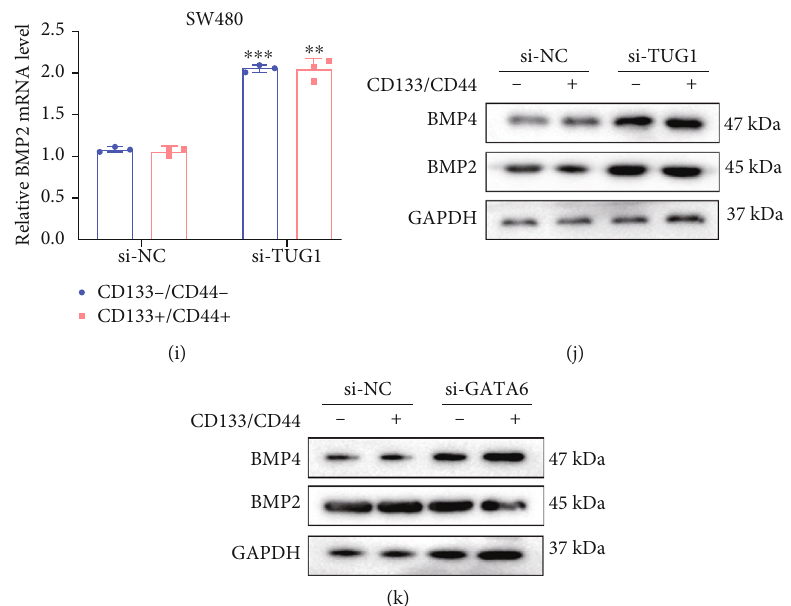
Figure 3: Analysis of the interaction between lncRNA TUG1 and GATA6. (a) RNA Interactome Database and COAD colon cancer database were applied to predict the transcription factors that had potential interactions with lncRNA TUG1 and were highly expressed in CRC. (b) RNA pull-down assay was conducted to verify the interaction between lncRNA TUG1 and ETV4, ASCL2, GATA6, and SOX9. (c) Veri fi cation of the interaction between lncRNA TUG1 and GATA6 by RNA immunoprecipitation assay. (d, e) si-TUG1 was transfected into CD133 - /CD44 - or CD133 + /CD44 + isolated from SW480 cells. The mRNA and protein levels of GATA6 were analyzed using qRT-PCR and Western blot. (f, g) si-TUG1 was transfected into CD133 - /CD44 - or CD133 + /CD44 + isolated from SW480 cells, and the cells were treated with 100 μ g/ml cycloheximide (CHX) for 0, 4, and 8h. Detection of the GATA6 protein level by Western blot. (h – k) si-TUG1 was transfected into CD133 - /CD44 - or CD133 + /CD44 + isolated from SW480 cells. The mRNA and protein levels of BMP4 and BMP2 were assessed using qRT-PCR and Western blot. ∗∗ P < 0 : 01 vs. si-NC or CD133 - /CD44 - . ∗∗∗ P < 0 : 001 vs. IgG or CD133 - /CD44 -